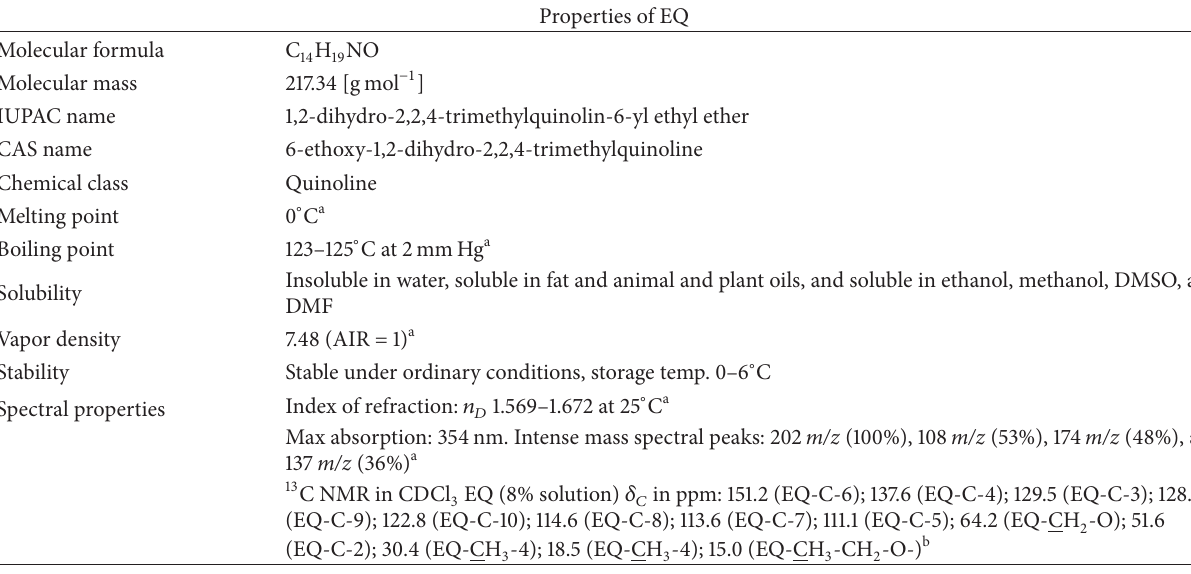
Table 2: Physical and chemical properties of